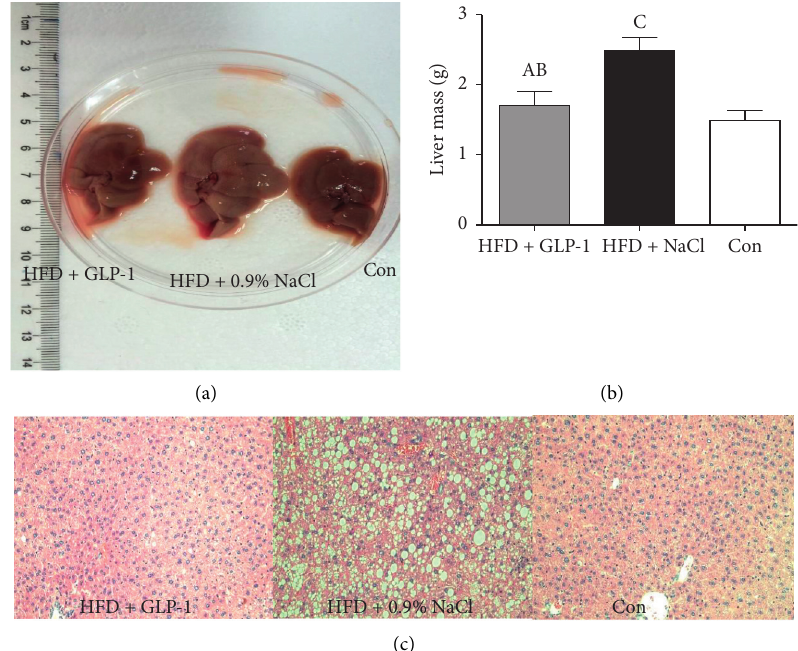
Figure 2: Comparison of livers among groups. Group A: HFD+GLP-1; Group B: HFD+NaCl; Group C: Con. (a) P � 0.001 vs. Group B; (b) P � 0.161 vs. Group C; (c) P < 0.001 vs. Group C.